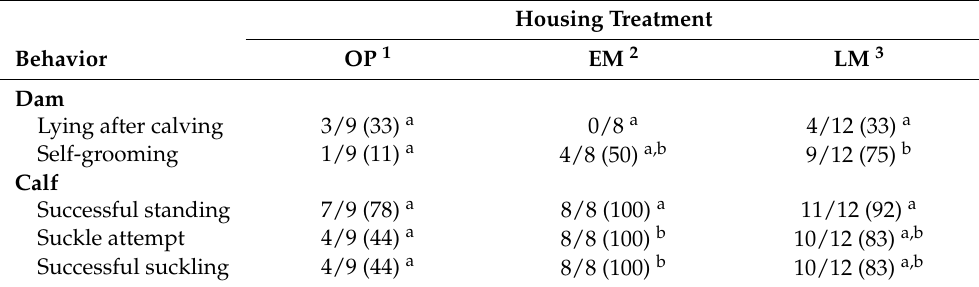
Table 3. Association of housing treatment on the number (and percentage) of dams and calves that performed different behaviors during the first 1.5 h after calving.